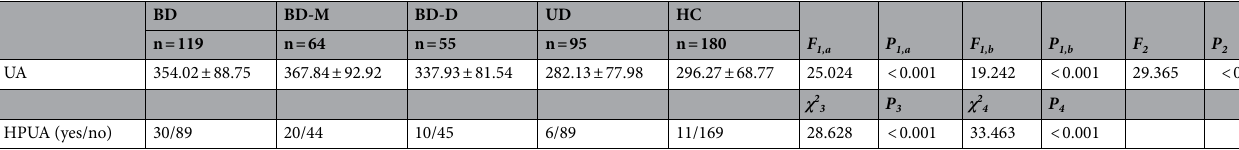
Effects of treatment on UA levels.